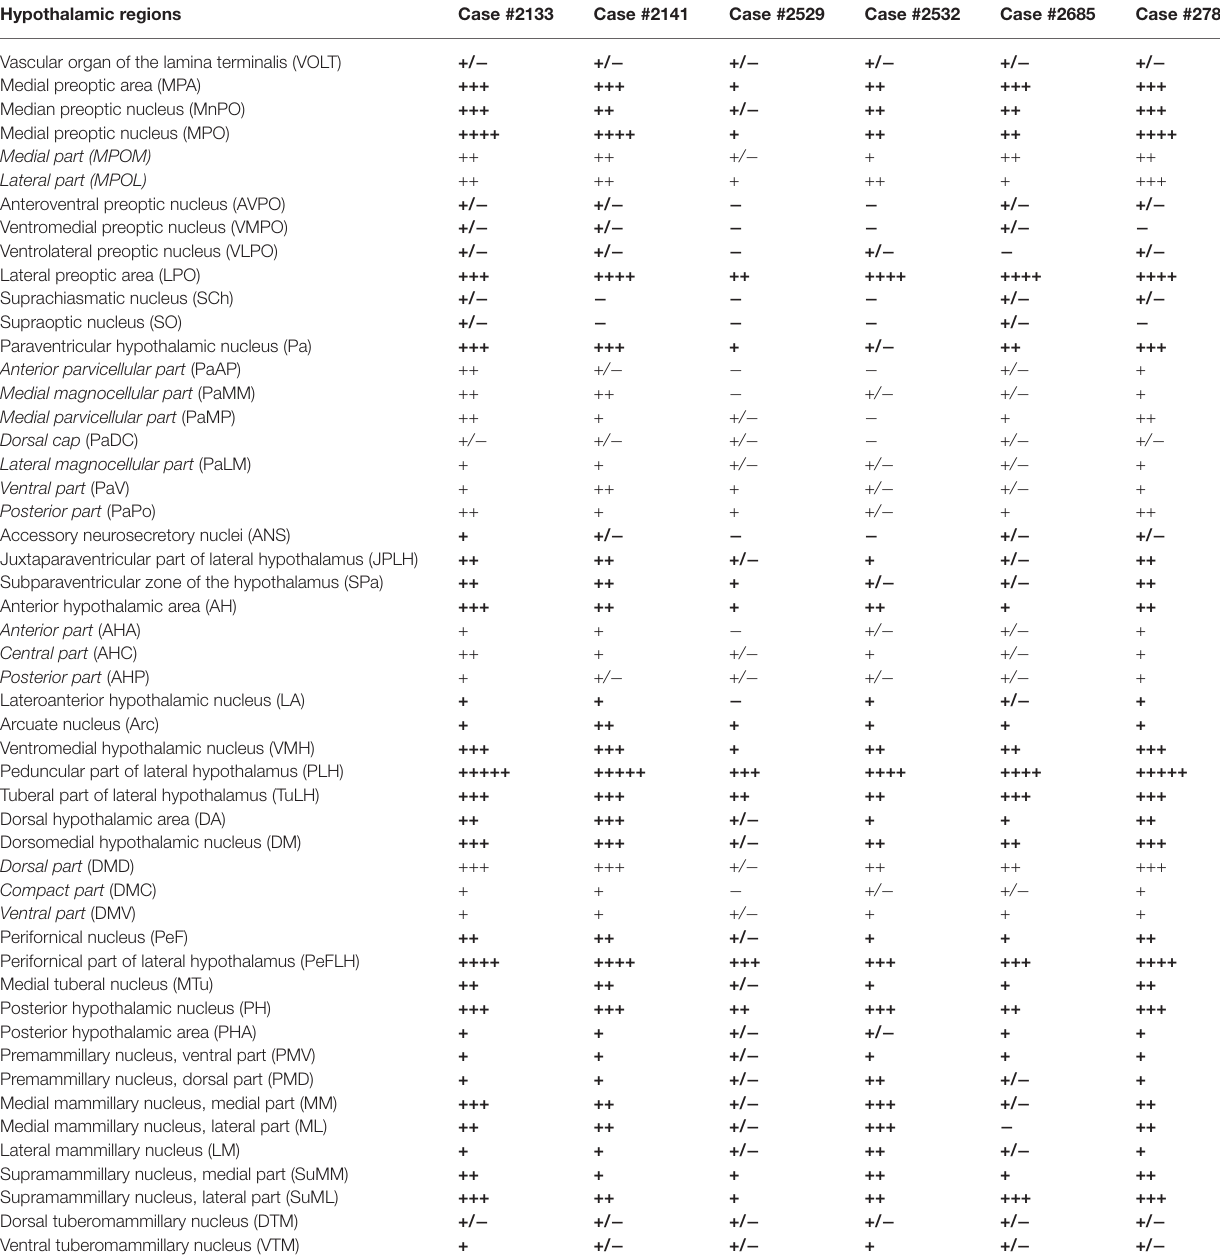
TABLE 2 | Relative abundance of retrograde labeled cells resulting from six separate injections of CTB into the ventral tegmental area (VTA) of male rats. Hypothalamic